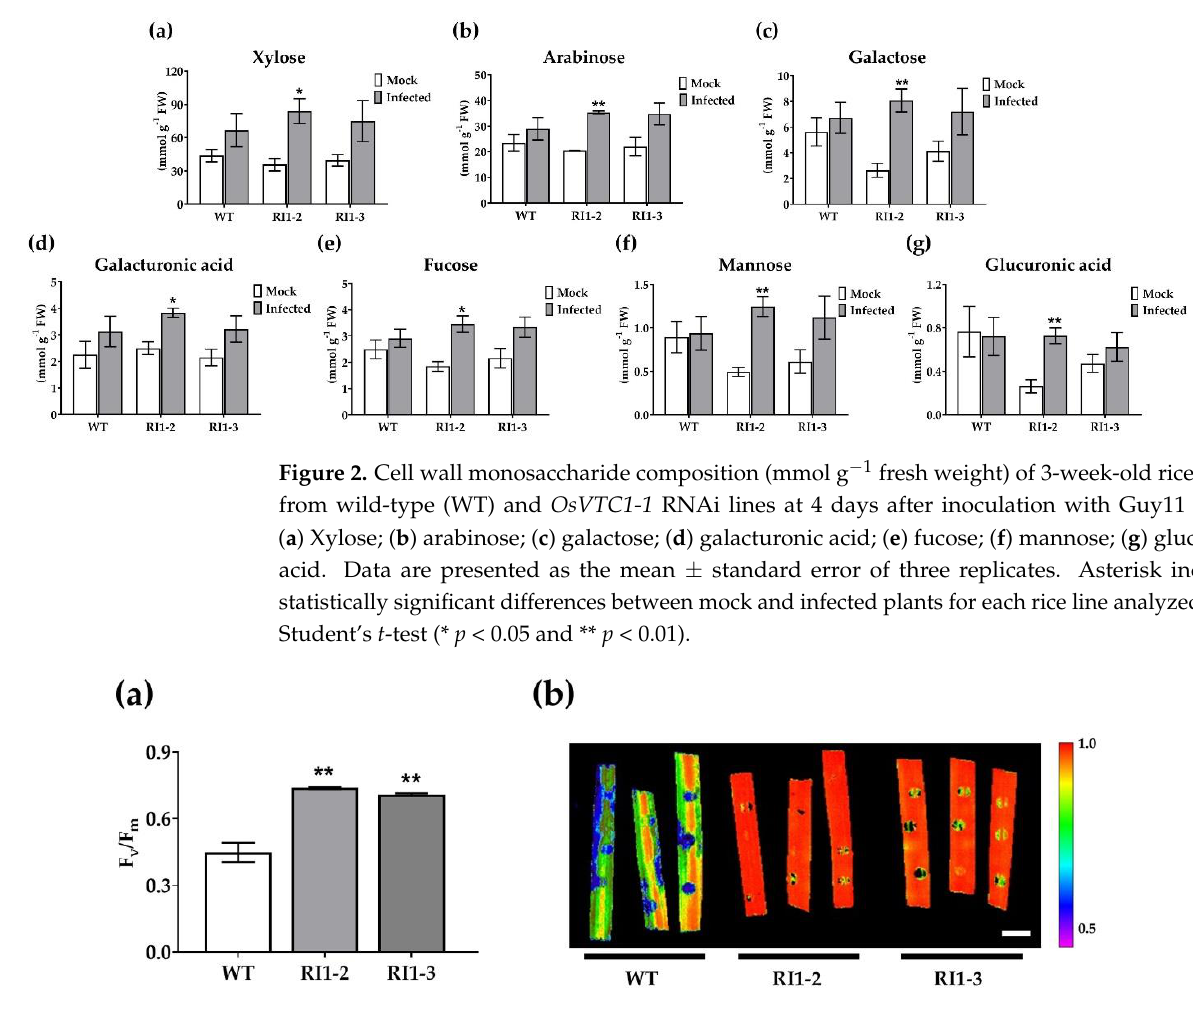
Figure 3. Leaf photosynthetic efficiency in wild-type (WT) and OsVTC1-1 RNAi lines (RI1-2 and RI1-3) at 5 days post inoculation with Guy11 isolate. ( a ) Maximal efficiency of PSII (F v /F m ); ( b ) chlorophyll fluorescence image showing photosynthetic activity across the leaf surface (scale bar = 1 cm). Data are presented as the mean ± standard error of three replicates. Asterisk indicates statistically significant differences from WT analyzed using Student’s t -test (** p < 0.01).